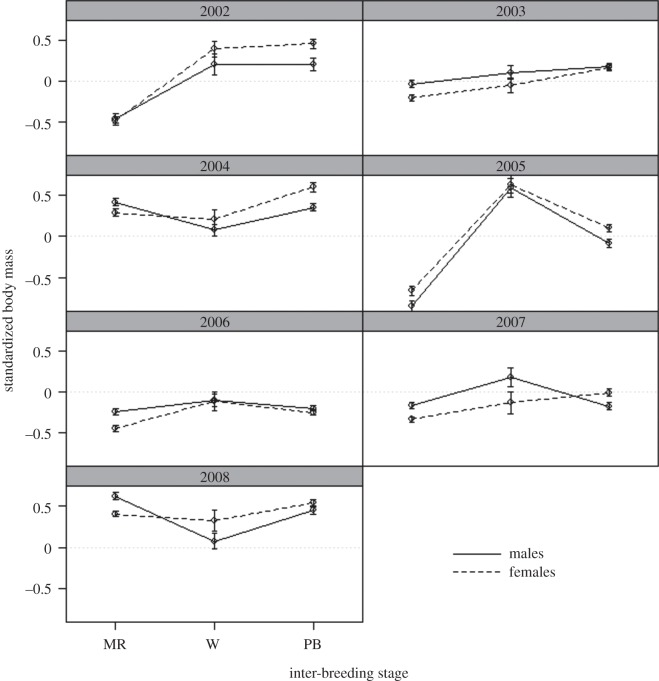
Mean standardized body mass (±s.e.) of male (solid lines) and female (dashed lines) little penguins in each inter-breeding season period (moult-recovery (MR), winter (July) (W), pre-breeding (PB)) of 7 years (2002–2008) at Phillip Island, Australia. The dotted line at zero provides a reference to the standard body mass for males and females throughout the study. Positive values indicate body mass higher than the standard and negative values are lower than standard.